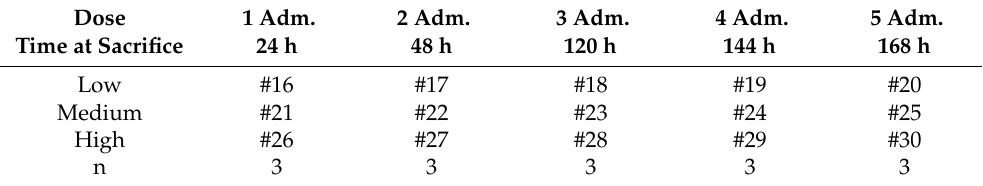
Table 1. Distribution of animals, dose, time, and number of administrations when they were sacrificed. (Time from hour 0 when the first administration was performed. In all cases, mice were sacrificed 24 h after its last administration). Dose 1 Time at Sacrifice